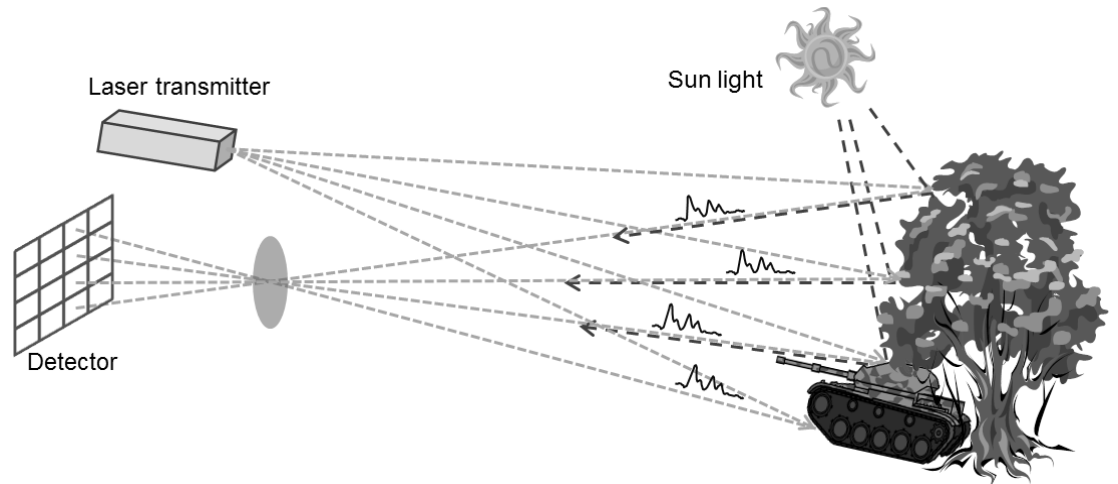
Figure 1. Principle of a LADAR sensor. The transmitter emits pulsed laser repetitively with a constant rate. The laser pulses are then backscattered on the surfaces of targets or background. Each pixel of the detector measures the travel time of the laser pulse by collecting the return pulse. The collected incident energy also includes noises such as sunlight and dark count due to thermal